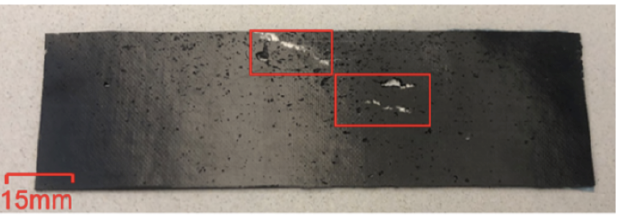
Figure 9. Defects on specimen: porosity (black features on the surface) and void (highlighted with red